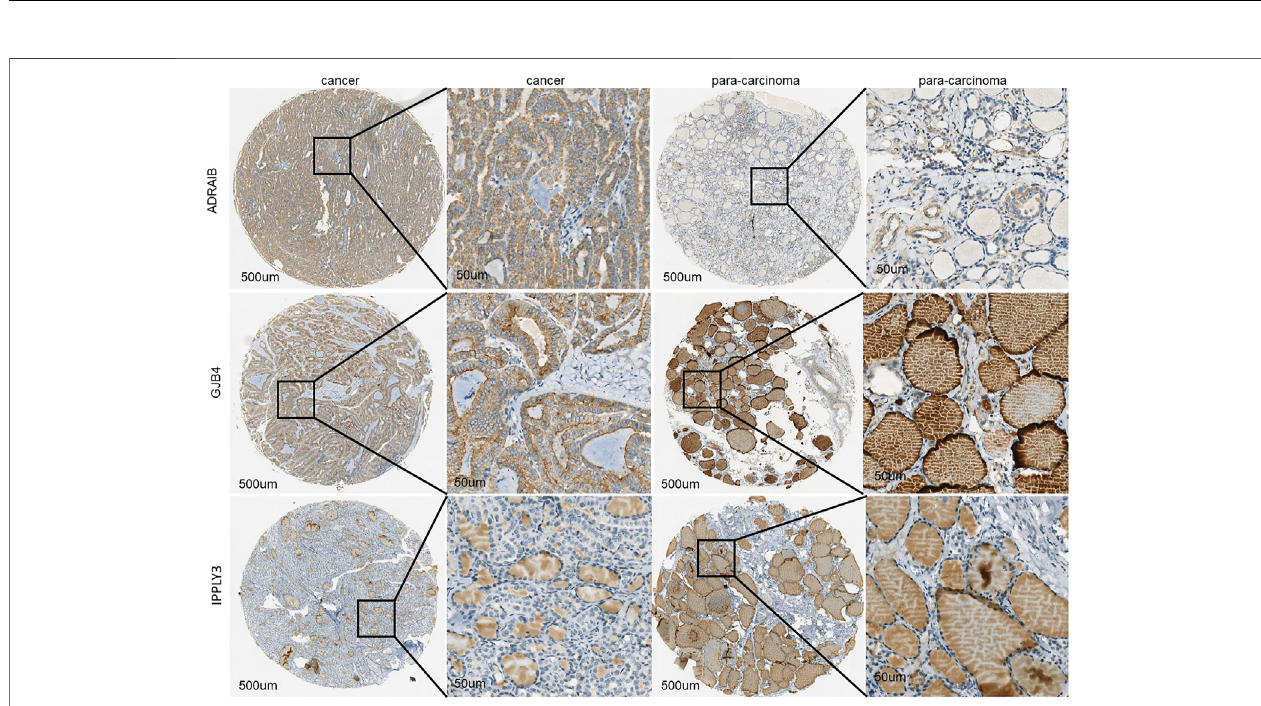
FIGURE5| TheimmunohistochemicalresultsofGJB4,RIPPLY3,andADRA1Bcharacteristicgenetissuechipsindicatedthattheexpressionintumortissueswas signi fi cantly higher than that in adjacent tissues.